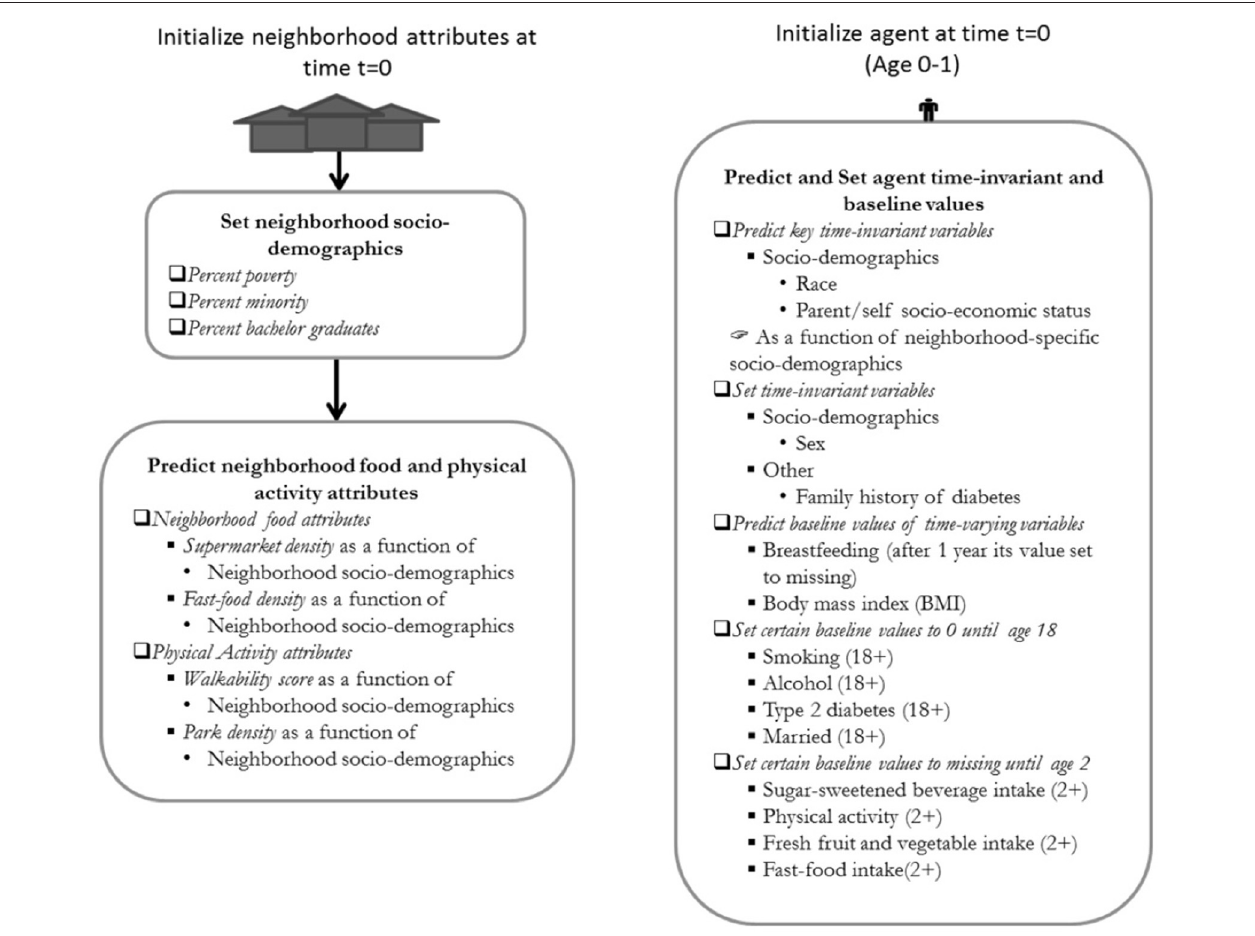
FIGURE 2 | Model initialization diagram of the ViLA-Obesity model. The neighborhood attributes are first initialized at time t = 0 and subsequently followed by the initialization of the agent. The neighborhood food and physical activity attributes are predicted as a function of neighborhood socio-demographics. The individual time-invariant variables are set to their baseline values or predicted from socio-demographic